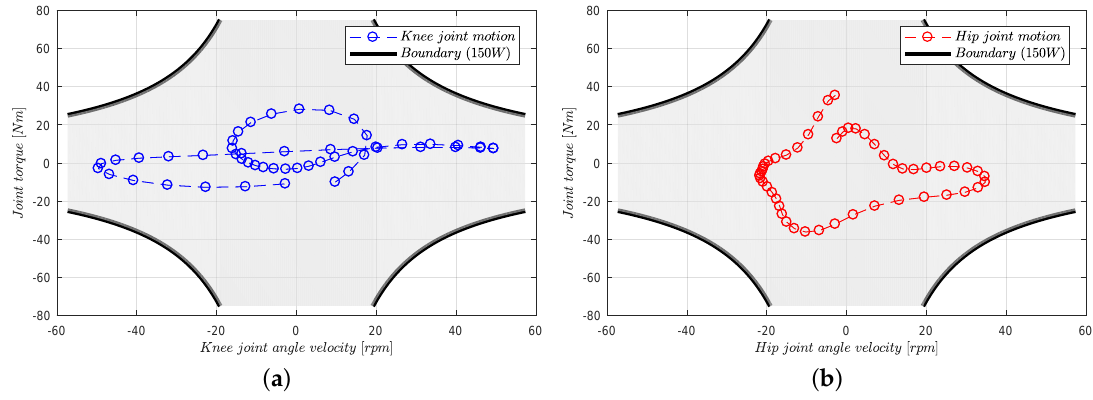
Figure 2. Provement of electric motor selection. For electric actuation, the power of the selected electric motors should cover the range of the joint torque during normal human walking. For safety concerns and efficiency, we chose the RE40 dc motor (150 W) from the Maxon Motor Company. ( a ) Motion range of the knee joint; ( b ) motion range of the hip joint.